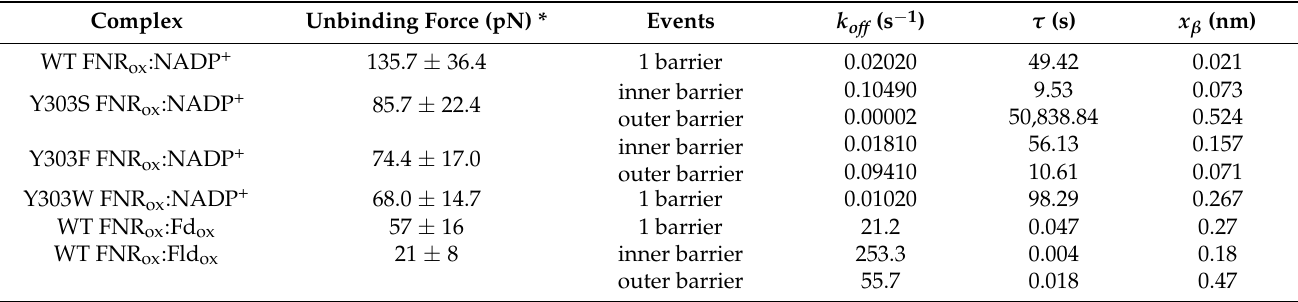
Table 1. Mechanical parameters for the dissociation of FNR ox :NADP + complexes. The values were obtained from fitting of data shown in Figure 11. Values for the AnFNR ox :Fd ox /Fld ox complexes were previously reported [33] and added here to facilitate discussion. Assays were performed in PBS/EDTA pH